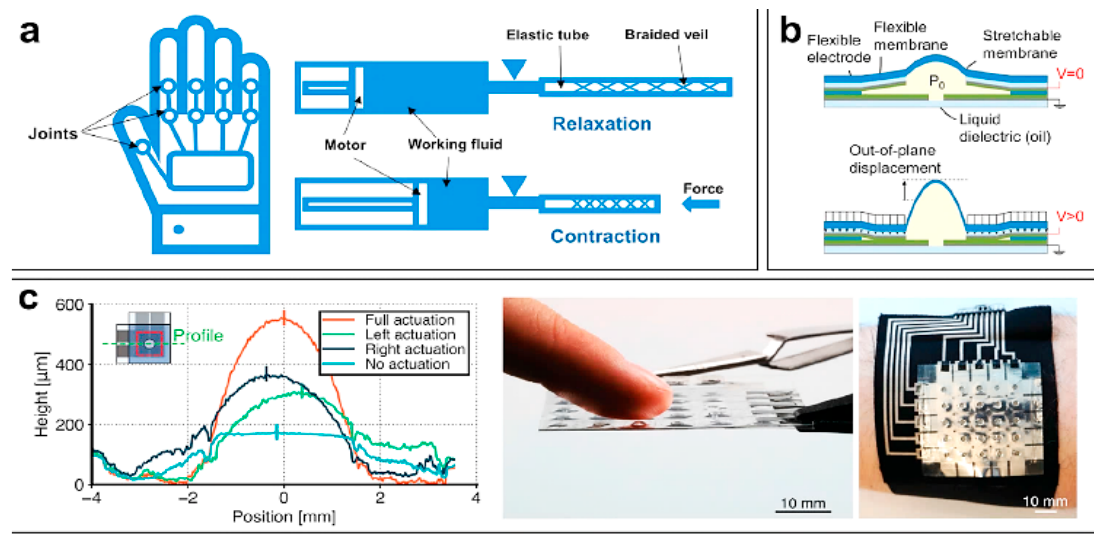
Figure 4. Examples of hydraulically driven tactile interfaces. Illustration of a hydraulic glove with a joint-stretching mechanism providing kinesthetic feedback ( a ). A diagram of a hydraulic actuator that changes the cavity to provide out-of-plane displacement for tactile feedback ( b ) [31]. An electrostatic mechanism controls the hydraulic actuators leading to dielectric normal and lateral motion as a result of cavity deformation ( c ) [31].